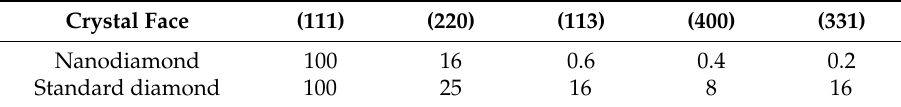
Table 5. Relative intensity of di ff raction peaks in XRD